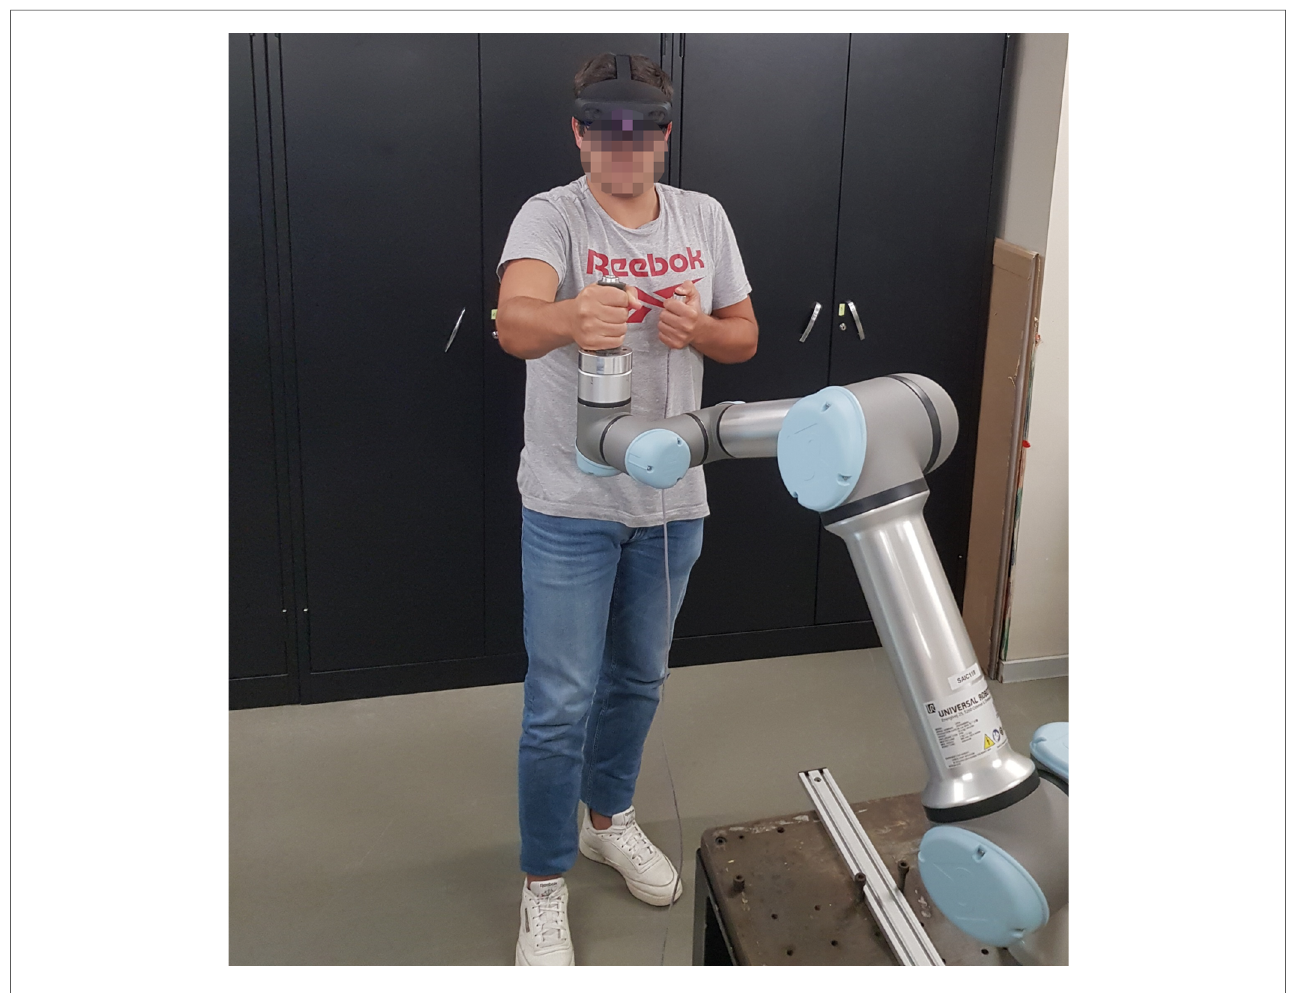
FIGURE 5 Participant using the